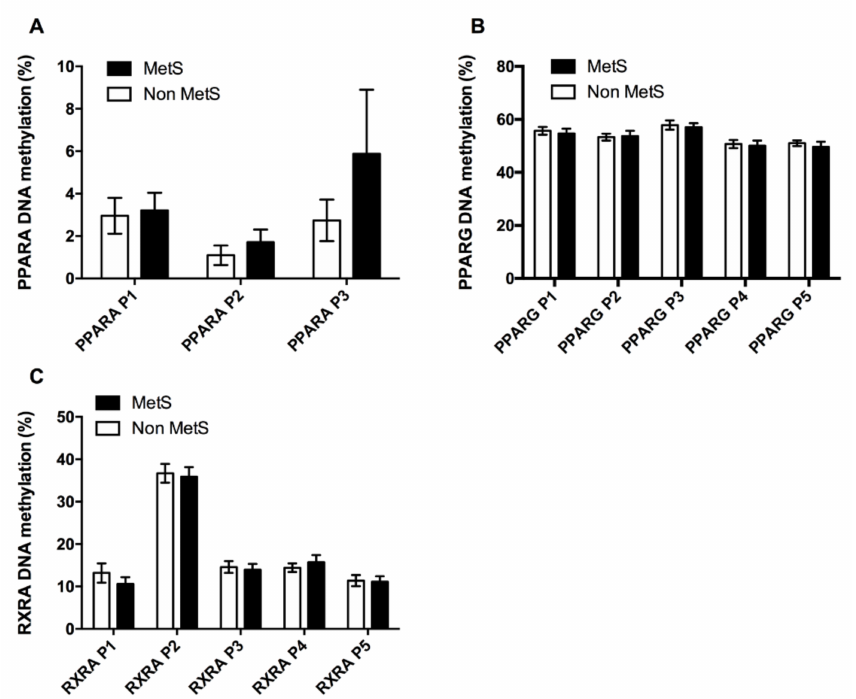
Figure 2. Adipogenic factors DNA methylation. DNA methylation profile across the CpG analyzed at the promoters of the adipogenic factors PPARA ( A ), PPARG ( B ), and the PPARs partner RXRA ( C ) in both, Non MetS and MetS groups. Values are given as the mean ± SE. Peroxisome proliferator-activated receptor alpha (PPARA); Peroxisome proliferator-activated receptor gamma (PPARG); Retinoid X receptor alpha